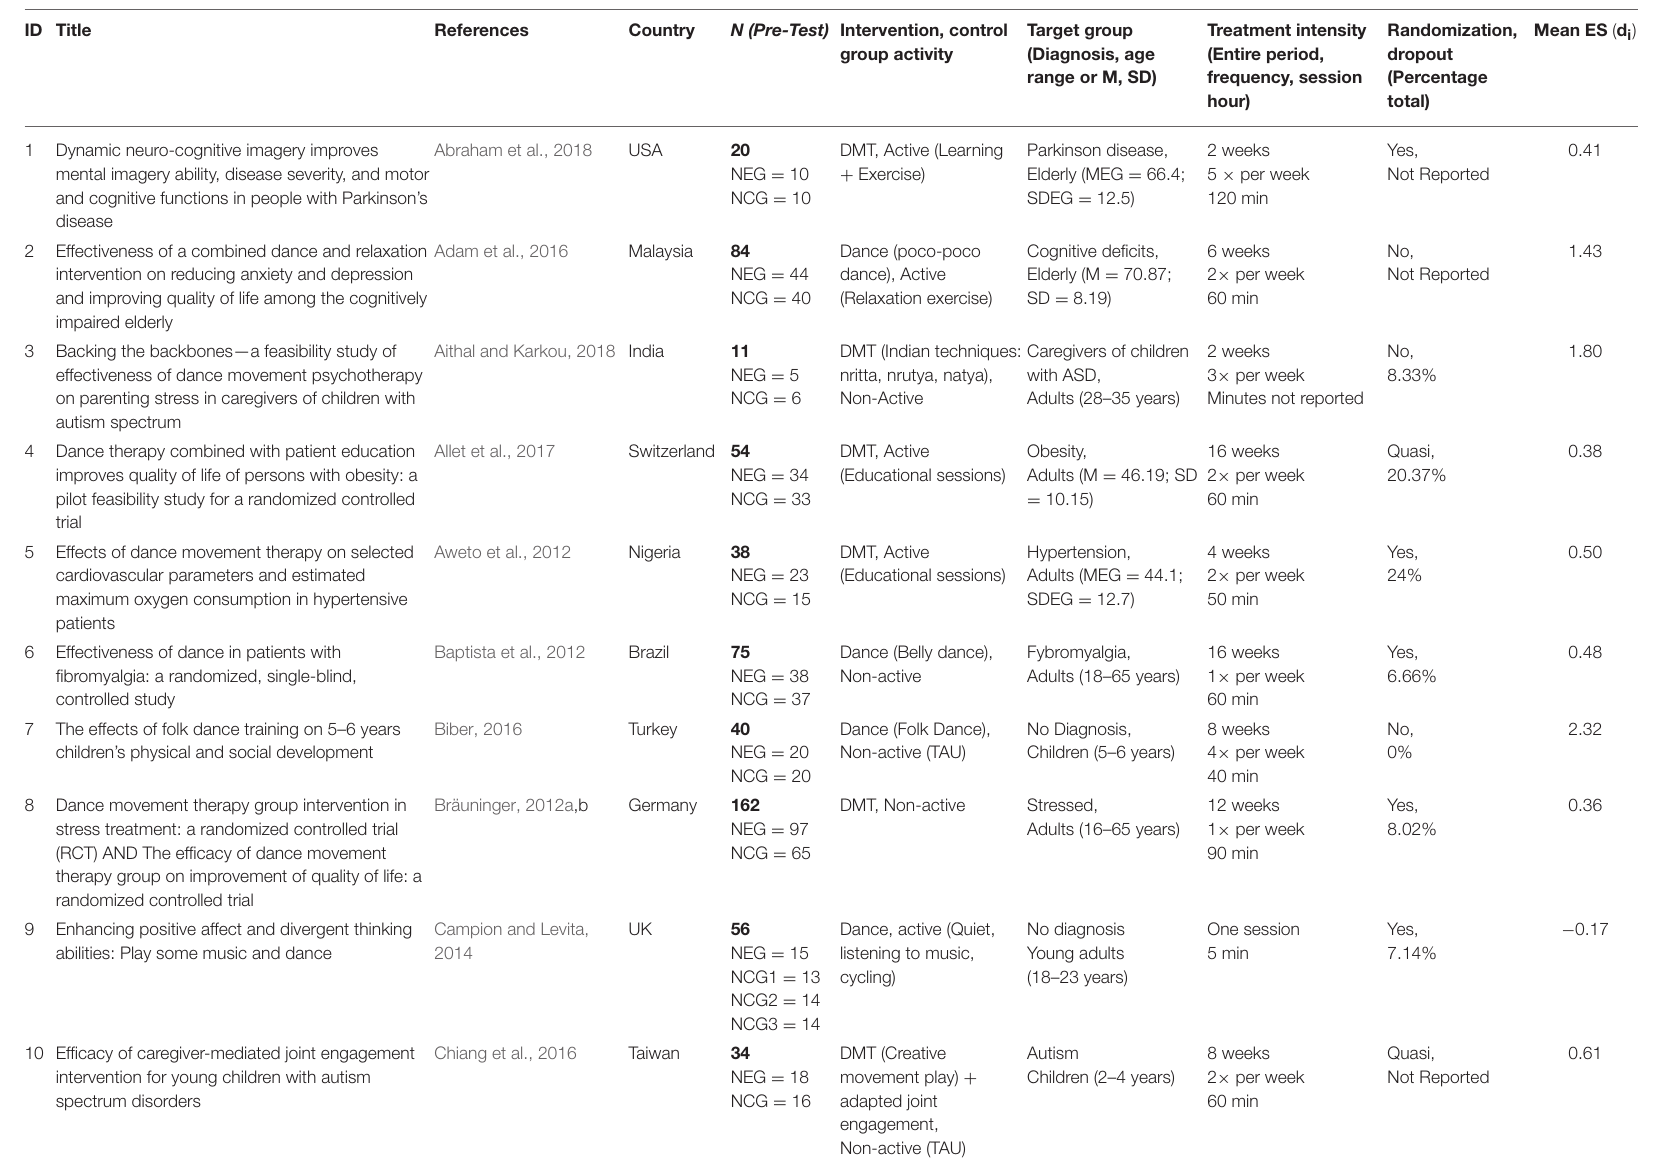
TABLE 1 | Study characteristics chart of the included